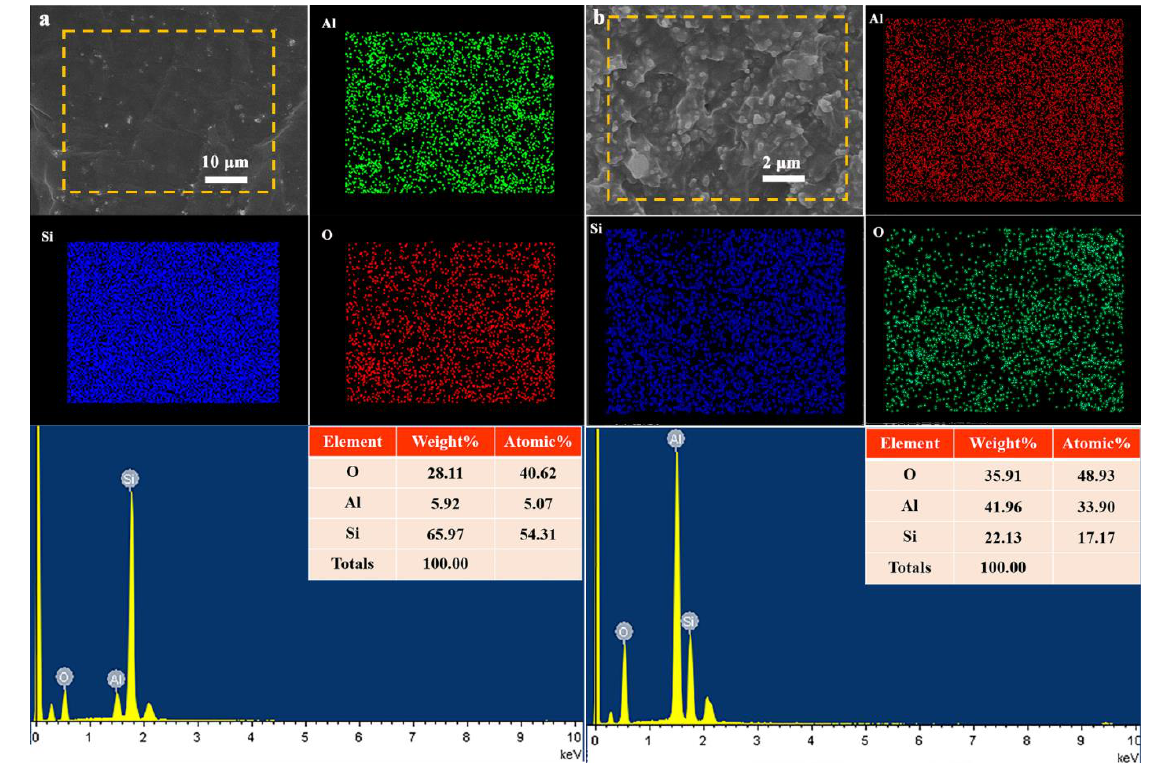
Figure 3. EDS scanning spectral results of the elements O, Al and Si: ( a ) 10 wt% B-Al 2 O 3 /SR composites and ( b ) 70 wt% B-Al 2 O 3 /SR composites.